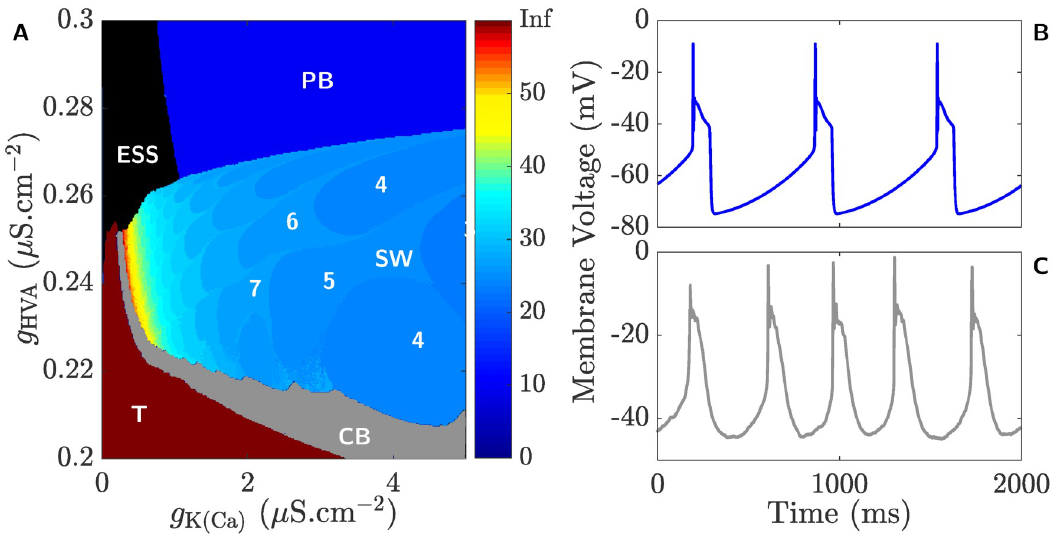
Fig 15. The effects of varying g HVA on the dynamics of the full system (1). A ) Color-map of the various regimes of behavior in the ( g K(Ca) , g HVA )-plane when g A = 10.2 μ S.cm − 2 . The square-wave bursting regime, labeled SW , is color-coded based on the number of spikes in their corresponding bursting orbits calibrated according to the color-bar to the right. Additional regimes are also present, including a tonic firing regime (labeled T ), a pseudo-plateau bursting regime (labeled PB ), a quiescent regime with elevated steady state (labeled ESS in black) and a chaotic bursting regime (labeled CB in gray). Since the full system (1) fires regularly in regimes T and PB , these regimes are also color-coded according to the color-bar to the right. For further clarity, the number of spikes in various regions of SW are displayed. B ) Time course of the membrane voltage V showing pseudo-plateau bursting obtained by setting g HVA = 0.77 μ S.cm − 2 , while keeping the other maximum current conductances at their default values listed in Table 2. C ) Electrical recording of one CSC showing pseudo-plateau bursting activity induced by the application of 20 mM 4-AP in the absence of a hyperpolarizing step